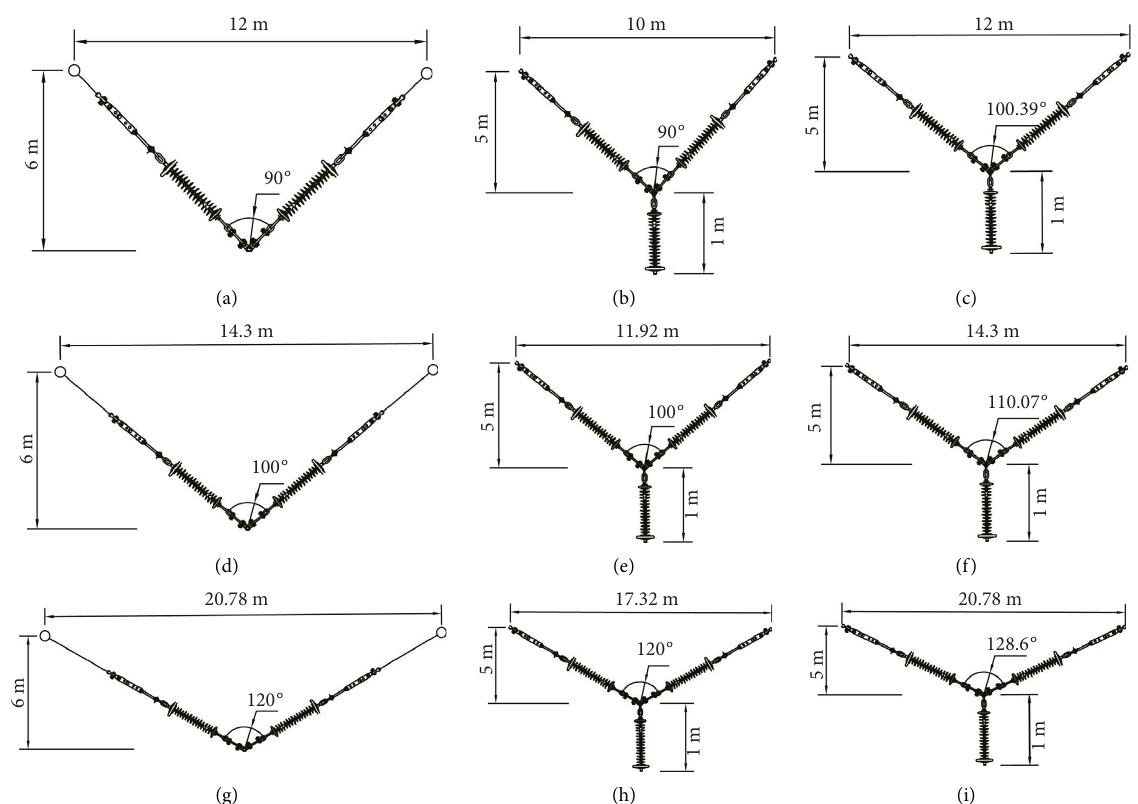
Figure 9: (a) Te V -type insulator string with a cross arm width of 12 m. (b) Te Y -type insulator string with a cross arm width of 10m. (c) Te Y -type insulator string with a cross arm width of 12m. (d) Te V -type insulator string with a cross arm width of 14.3m. (e) Te Y -type insulator string with a cross arm width of 11.92m. (f) Te Y -type insulator string with a cross arm width of 14.3 m. (g) Te V -type insulator string with a cross arm width of 20.78m. (h) Te Y -type insulator string with a cross arm width of 17.32m. (i) Te Y -type insulator string with a cross arm width of